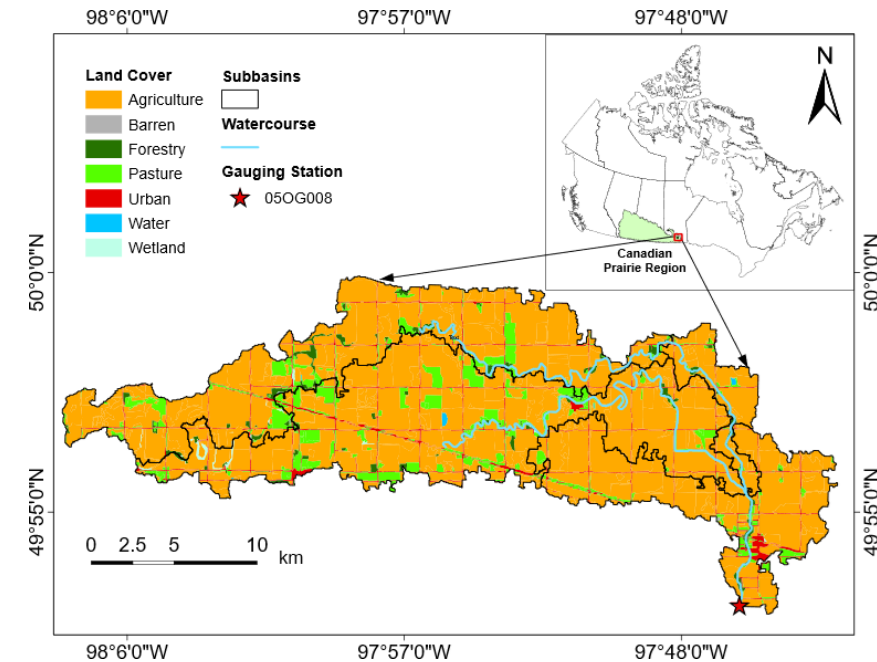
Figure 1. Location and land cover of the La Salle River basin (LS-05OG008) used for model simulations (AAFC,